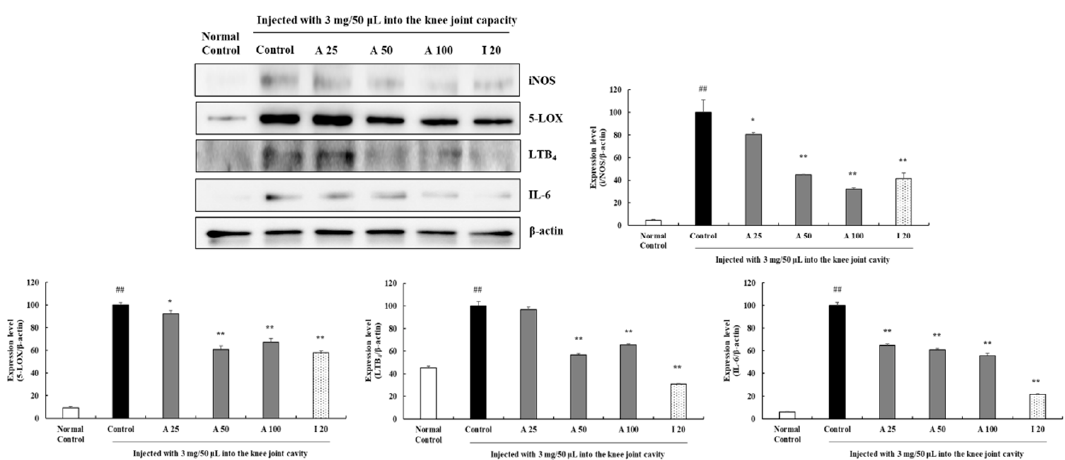
Figure 7. Effects of AyuFlex ® on the expression of iNOS, 5-LOX, LTB 4 , and IL-6 in arthrodial cartilage. The expression of iNOS (135 kDa), 5-LOX (78 kDa), LTB 4 (36 kDa), and IL-6 (25 kDa) was measured by western blotting. Protein bands were quantified utilizing ImageJ. As the control for normalization, β -actin was utilized. The results are expressed as the mean ± SEM of independent experiments ( n = 3 / group). A, AyuFlex ® ; I, Ibuprofen. * p < 0.05 and ** p < 0.01, in comparison with the MIA-induced control group; ## p < 0.01, in comparison with the non-MIA induced control group.